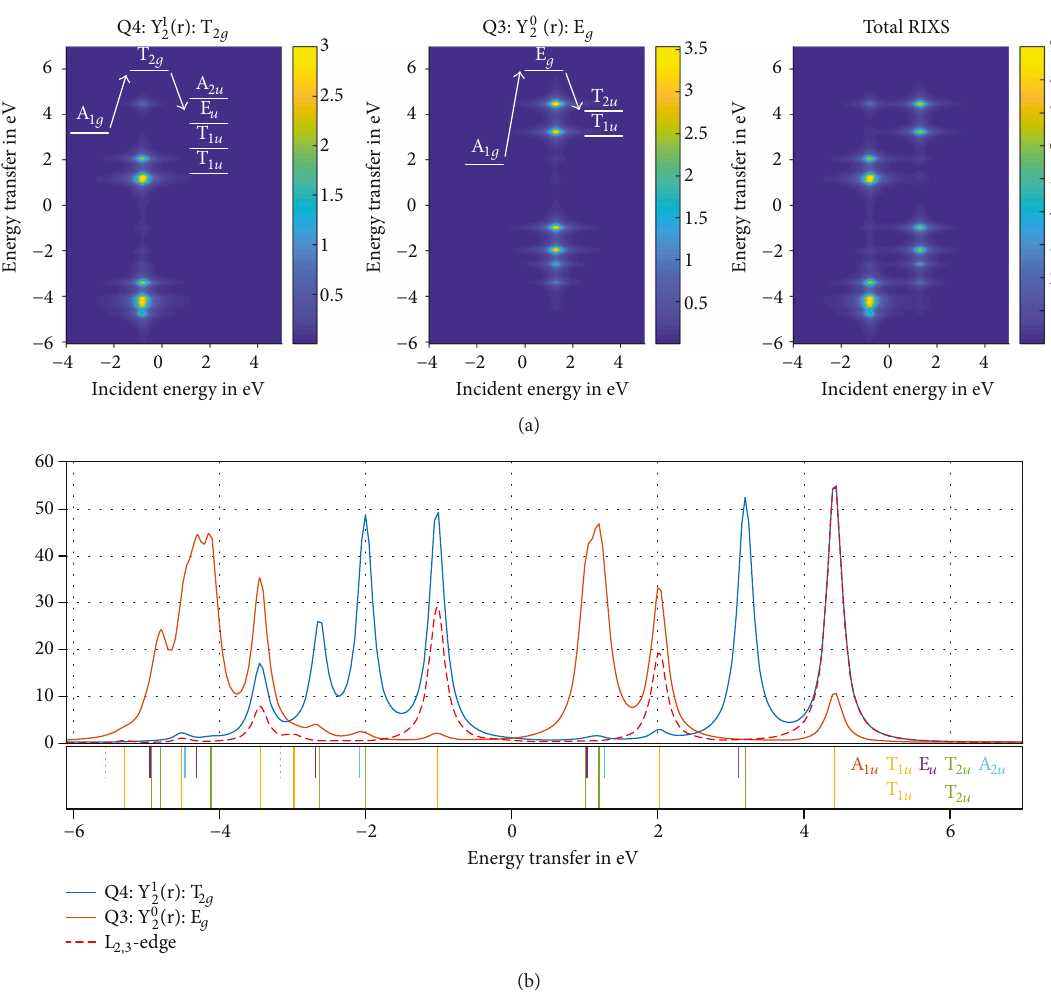
Figure 14: (a) Calculation of the 1s2p RIXS spectra for Ti 4+ (3d 0 ) with 10D q = 2 1eV separated into the quadrupole components Y m m = 0 , 1 and l = 2 ) in spherical symmetry. They translate into the T scheme insets illustrate the corresponding pathways. (b) The corresponding 2p XES projections onto the energy transfer axis for the two quadrupole components and the calculated 2p XAS (L